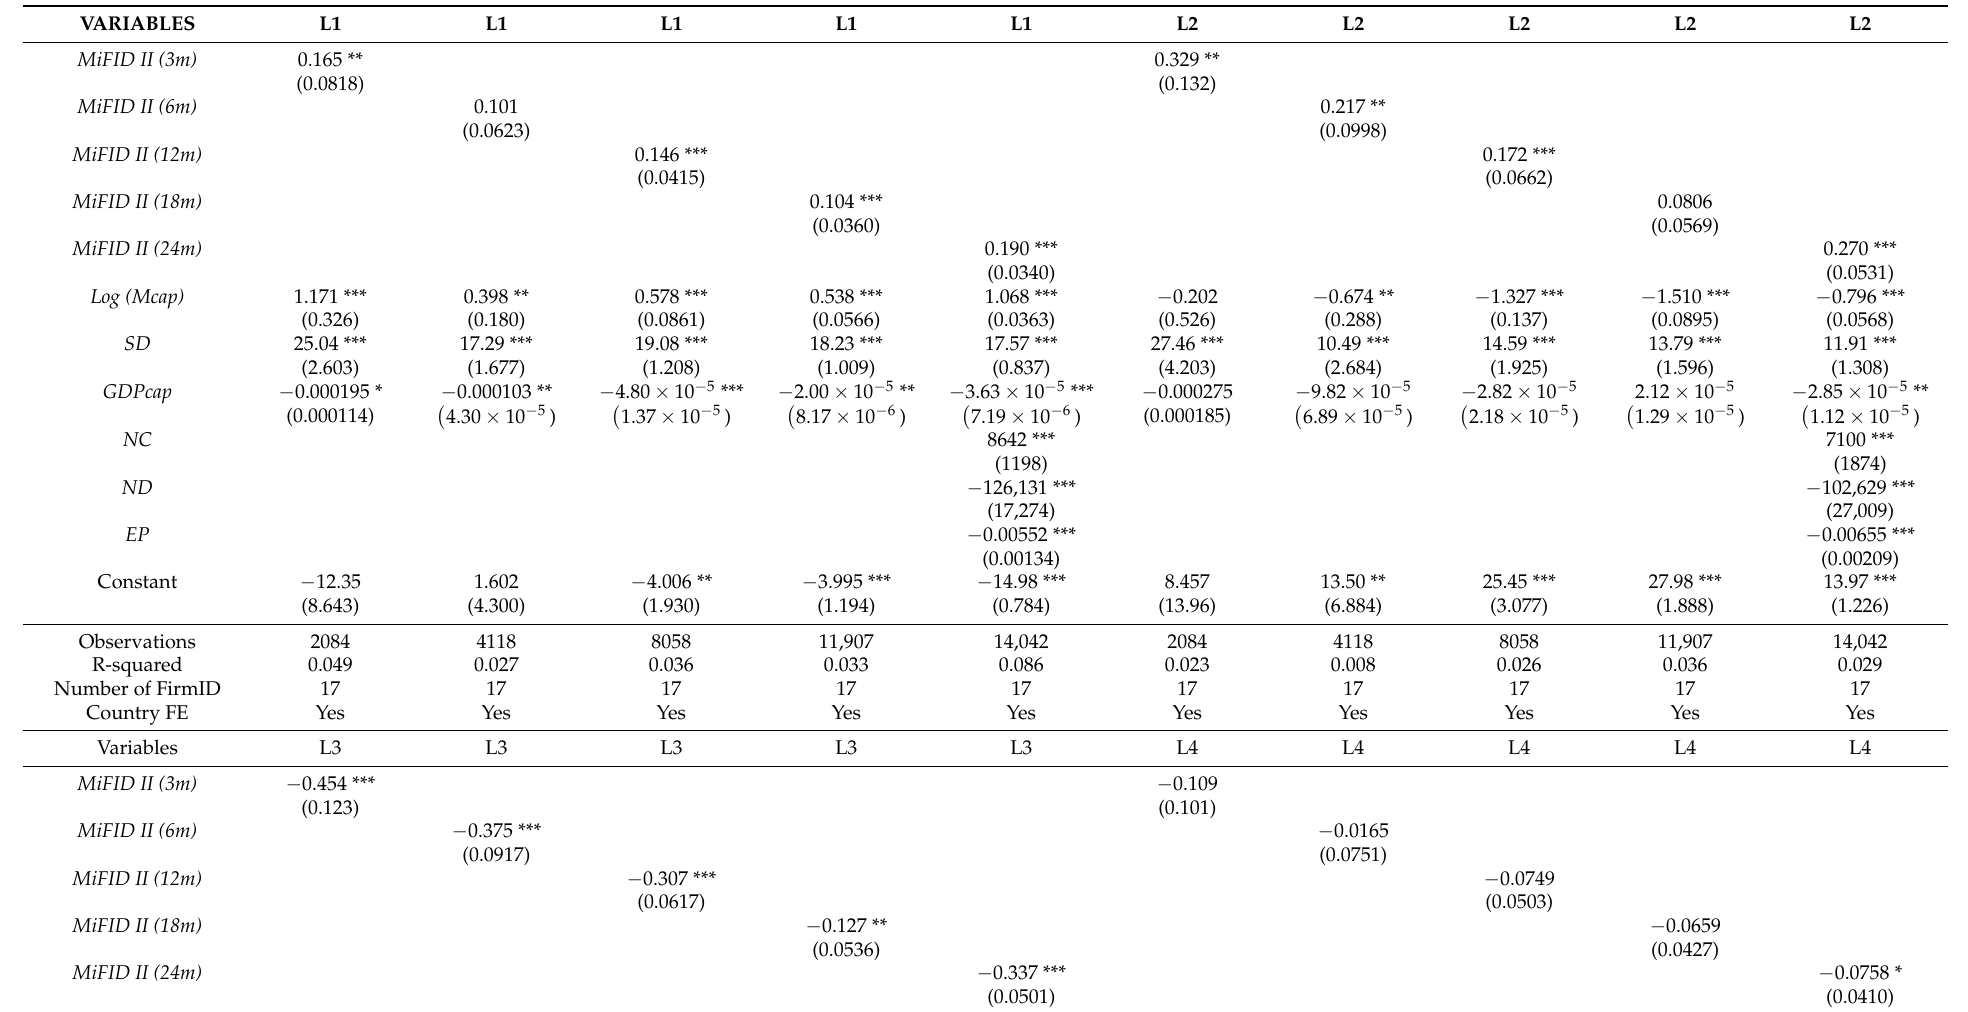
Table 3. Impact of MiFID II on Romanian stock market